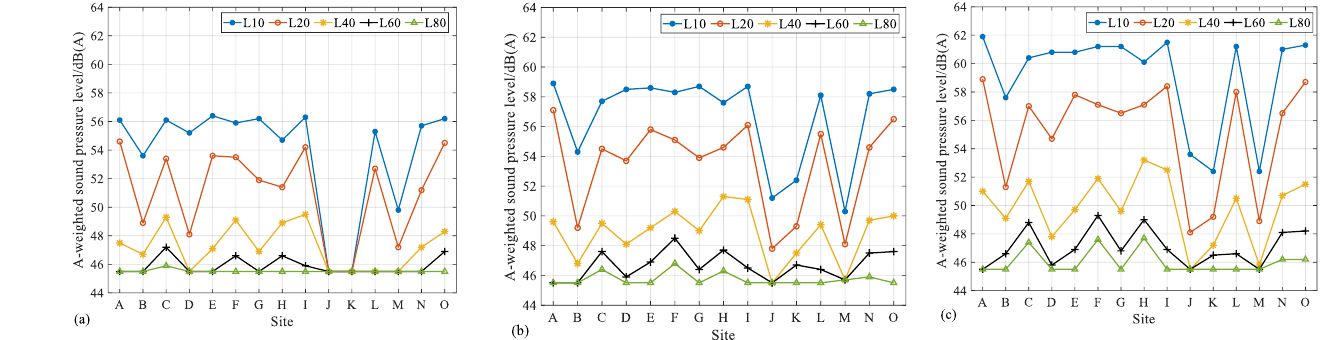
Figure 5. Noise distribution indices, L n , of the fifteen sites under different numbers of air filters (( a ) two air filters; ( b ) four air filters; ( c ) six air filters). (( a ) two air filters; ( b ) four air filters; ( c ) six air